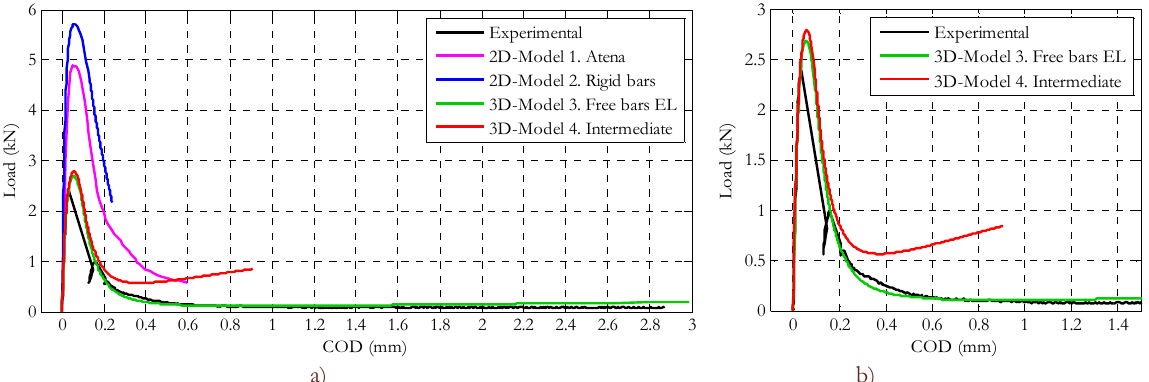
Figure 8: Load-COD curves for specimen 1: a) all modes including 2D model, and b) zoom detailing only 3D models and experimental results.